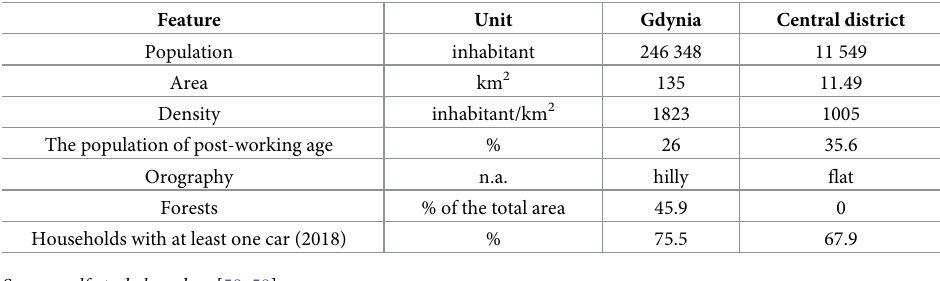
Table 1. Basic features of the central district and the whole city of